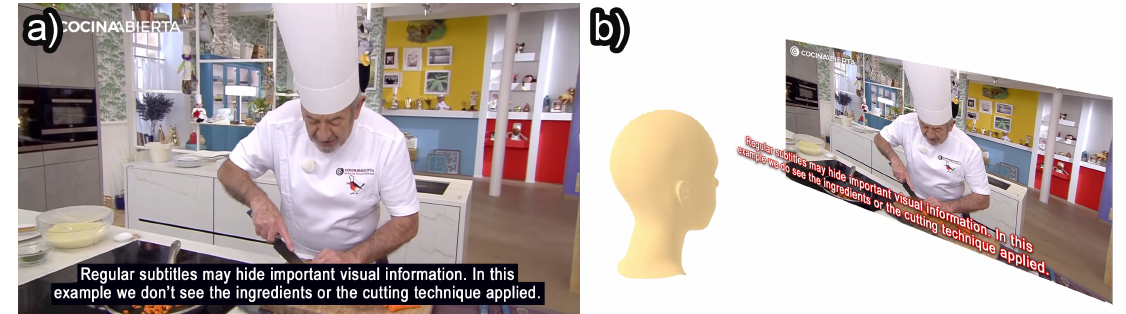
Figure 15. ( a ) Traditional subtitles on a regular screen. ( b ) Using SliceView to render subtitles at different depths, enabling the user to change the focal point to reveal partially occluded